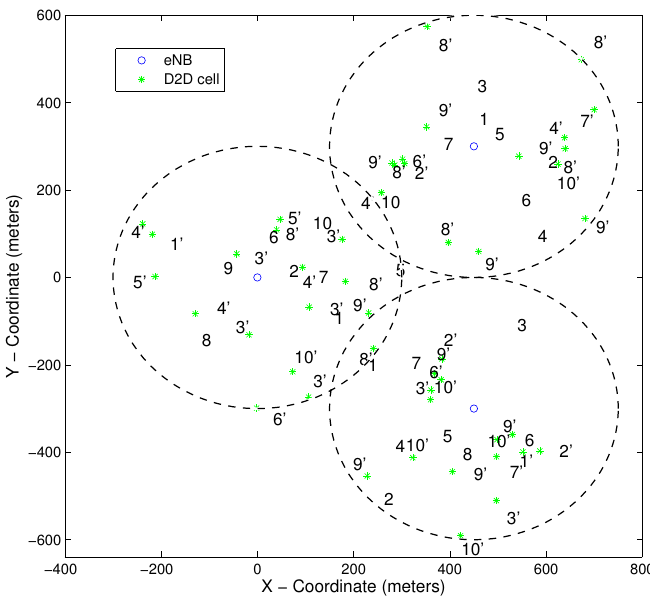
Figure 3. Topology of the final RB